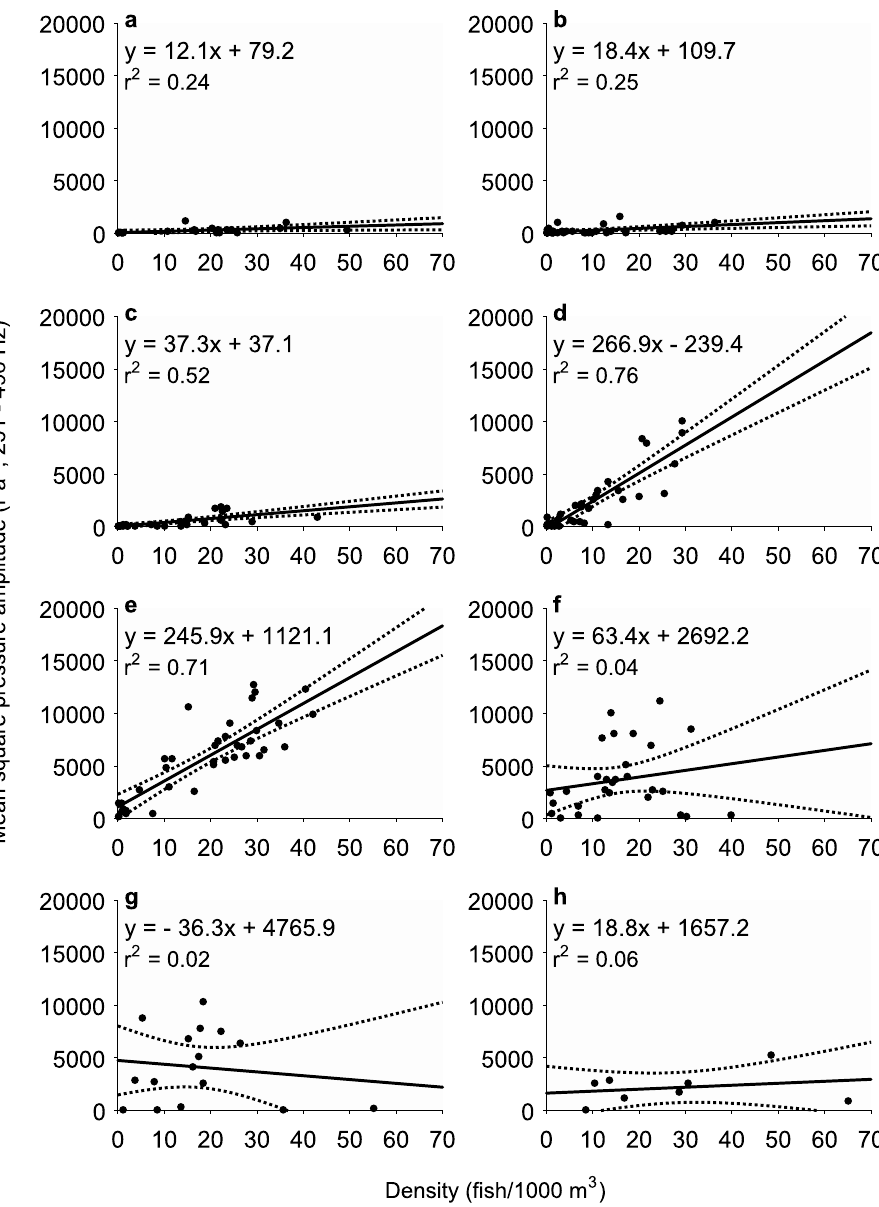
Figure 5. Relationship between sound levels and fish density over one-hour periods. Regressions of mean square pressure amplitude ( p 2 ; Pa 2 ; 251–498 Hz) versus fish density ( ρ ; fish/1000 m 3 ) from ( a ) 3–2 hours before high tide, ( b ) 2–1 hours before high tide, ( c ) 1–0 hours before high tide, ( d ) 0–1 hours after high tide, ( e ) 1–2 hours after high tide, ( f ) 2–3 hours after high tide, ( g ) 3–4 hours after high tide, and ( h ) 4–5 hours after high tide. Dotted lines indicate 95% confidence intervals. Densities are mean densities per 150-m survey length that were nearest in space and time to sound measurements. See Supplementary Fig. S3 for hourly relationships using mean density per 300-m survey